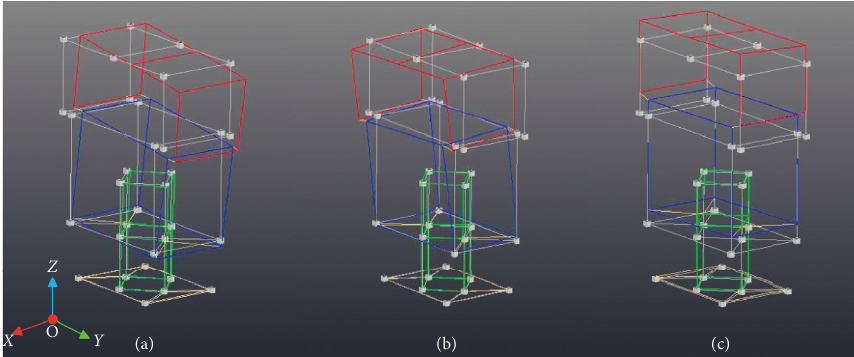
Figure 6: Previous three steps mode shapes of the disc spring system in experiment.